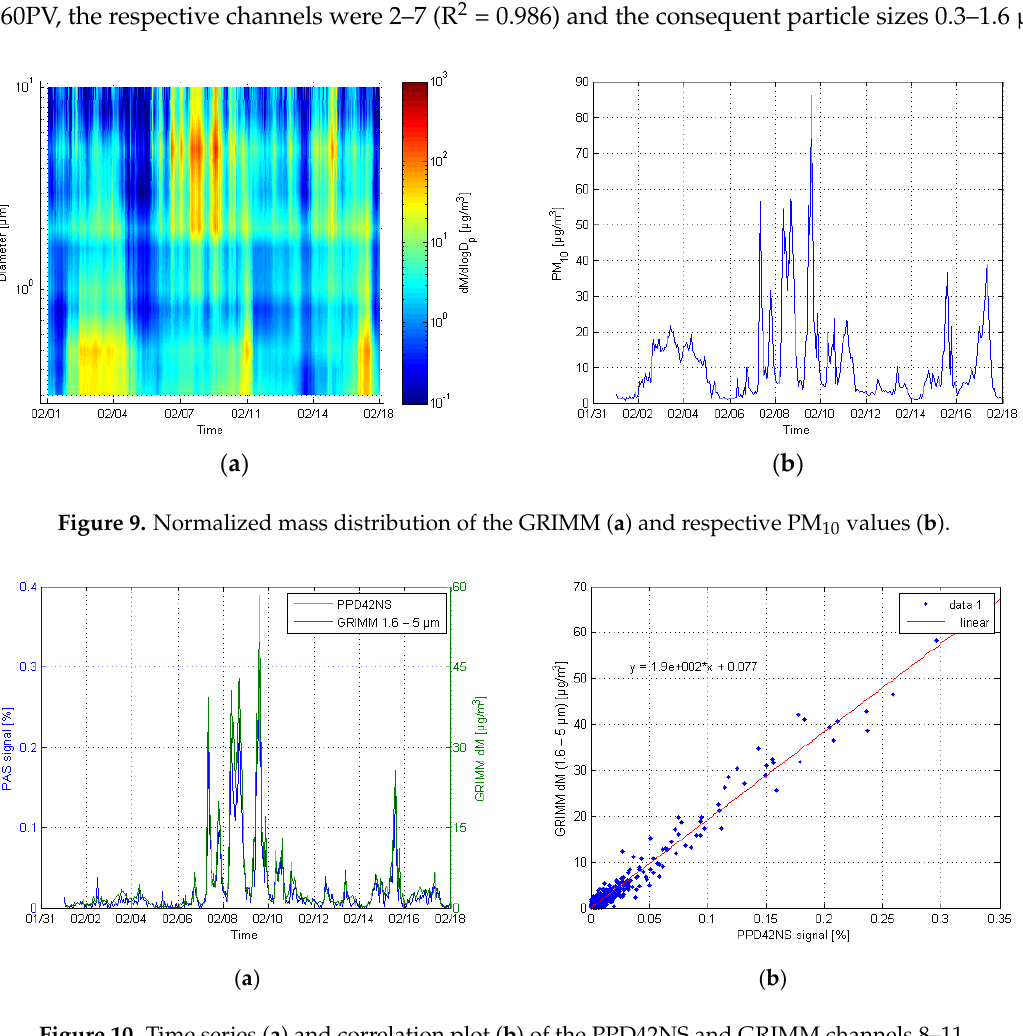
Figure 10. Time series ( a ) and correlation plot ( b ) of the PPD42NS and GRIMM channels 8–11.